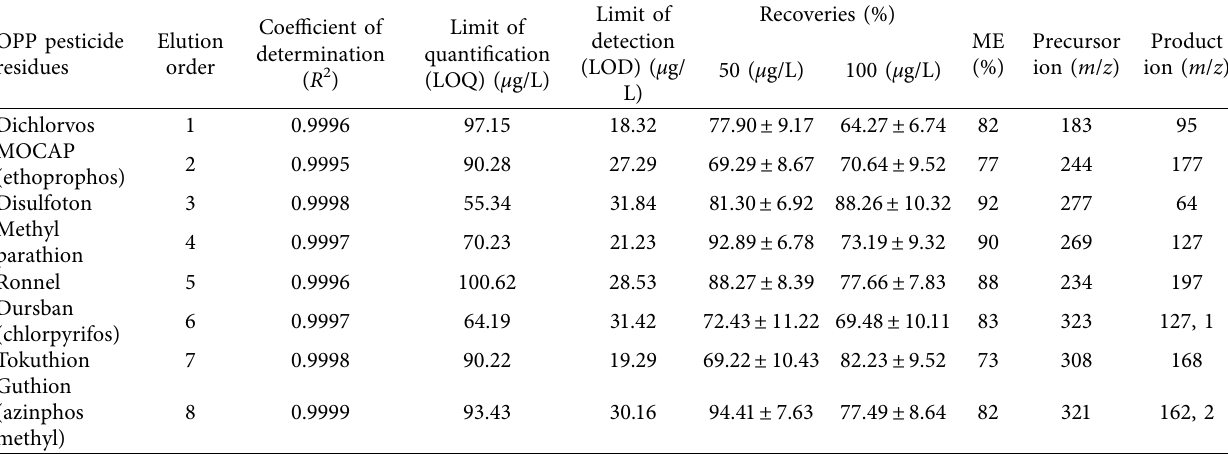
Table 1: The elution order, limit of detection, limit of quantification, coefficient of determination ( R 2 ) values, recovery rate, matrix effect (%), precursor ion ( m / z ), and product ion ( m / z ) of OP residues.